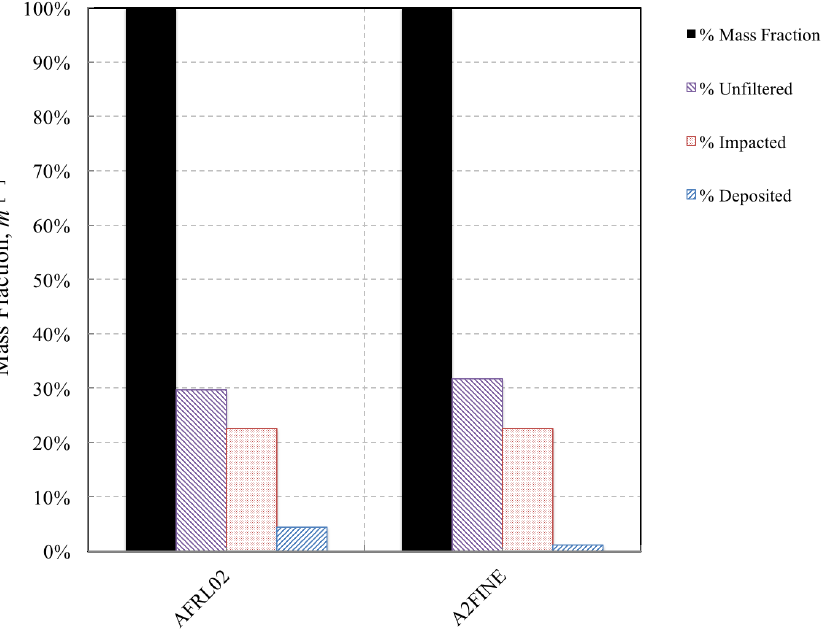
Figure 12. Breakdown of changes in dust mass fraction between inlet and NGV for two test